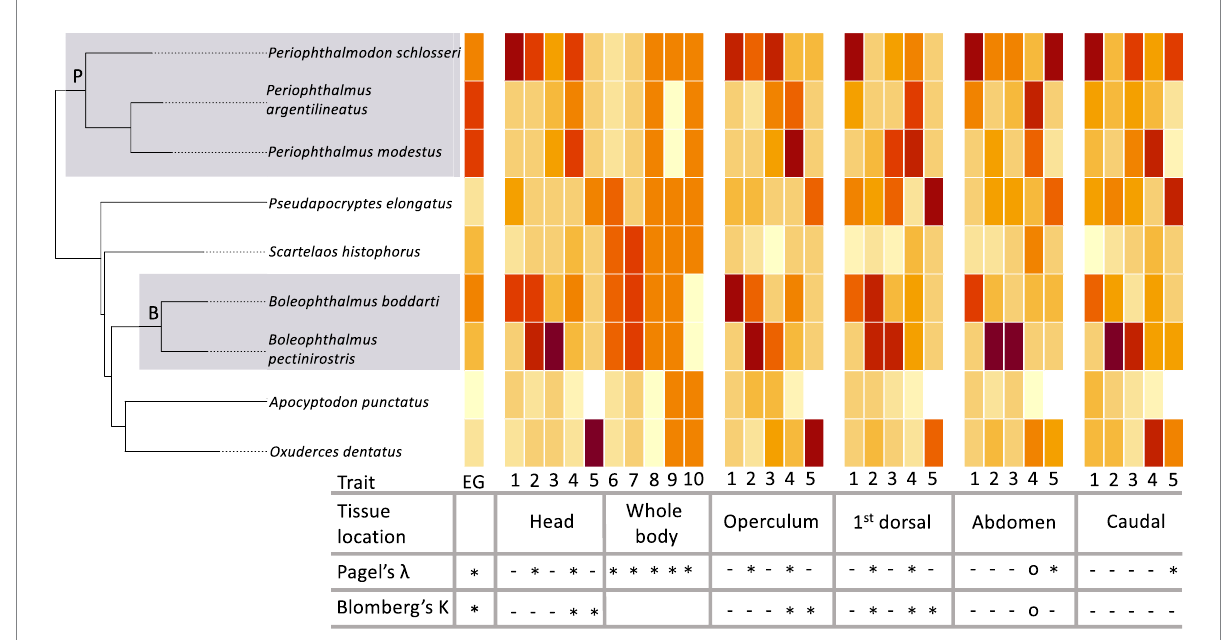
FIGURE 2 Pruned phylogeny (from McCraney et al., 2020) and a heatmap of associated trait values. Traits estimation based on mean values of each species which is based on mean values for each. Traits include: (1) number of scale layers (#), (2) tier of middle cells (#), (3) middle layer thickness ( μ m), (4) capillary density (#/mm), (5) diffusion distance ( μ m), (6) dermal bulge, (7) papilla, (8) Intra-epidermal capillary (skin), (9) mucous cells, and (10) chloride cell. Traits 6–10 are presence/absence across the full specimen. Dark colors = higher/presence. Light colors = low/absence trait values (see Supplementary Table 2 for actual values). Shaded boxes indicate clade P and clade B which have prolonged emersion. Table below represents phylogenetic signal based on Pagel’s λ and Blomberg’s K (See supplementary Table 4 for actual values). Traits and tissues combinations that show a strong phylogenetic signal are denoted with an “ ∗ ” ( λ > 0.9, K > 1.0), traits and tissues combinations that show an intermediate phylogenetic signal are denoted with an “o” (0.5 < λ < 0.9, 0.9 < K < 1.0), and traits and tissues combinations that show a little to no phylogenetic signal are denoted with a “-” ( λ < 0.5, K < 0.9). Blomberg’s K was not calculated for the whole body binary